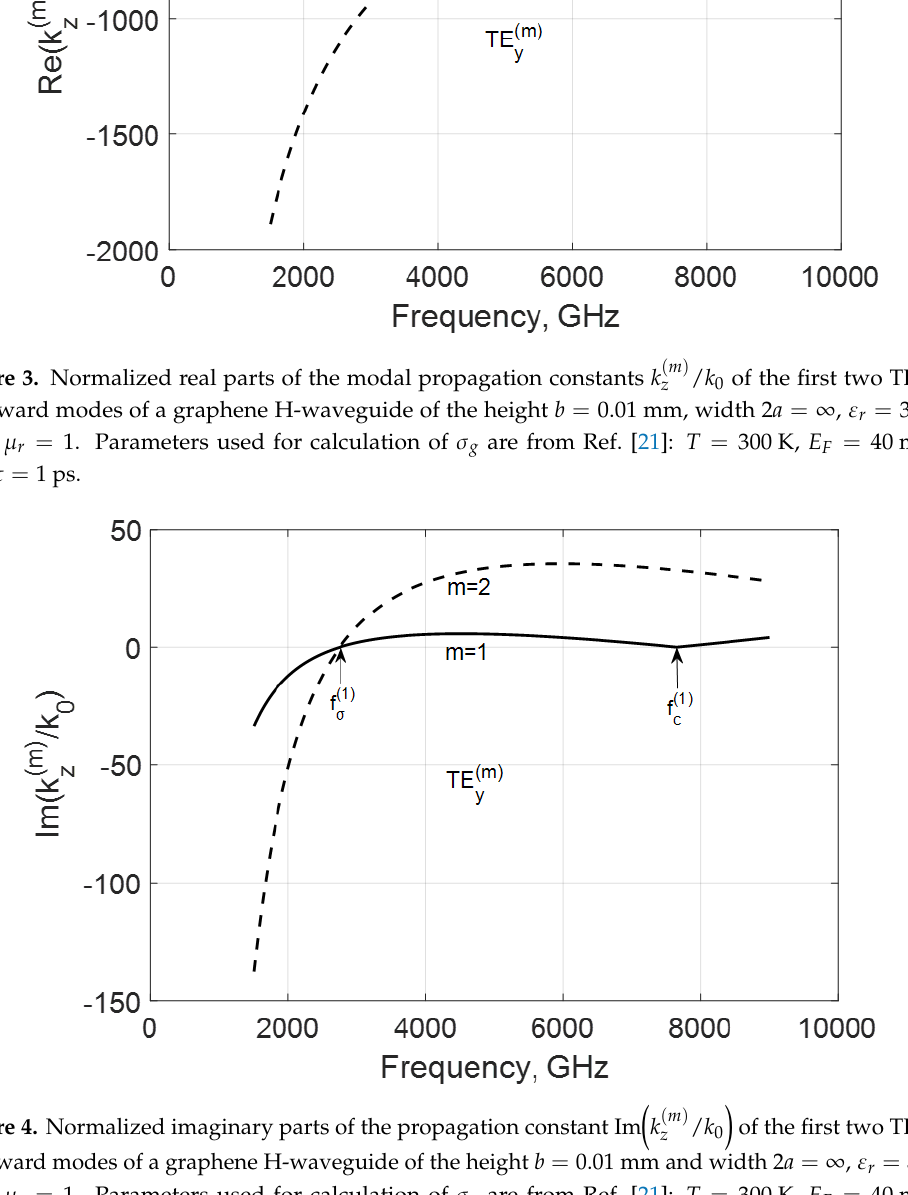
Figure 4. Normalized imaginary parts of the propagation constant Im backward modes of a graphene H-waveguide of the height b = 0.01 mm and width 2 a = ∞ , ε r = 3.84, and µ r = 1. Parameters used for calculation of σ g are from Ref. [21]: T = 300 K, E F = 40 meV, and τ = 1